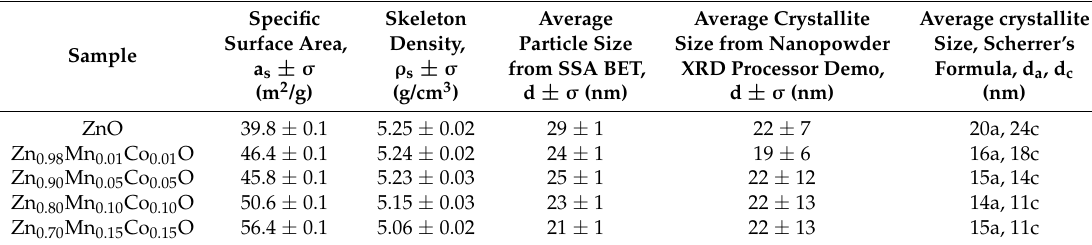
Table 8. Characteristics of the NP